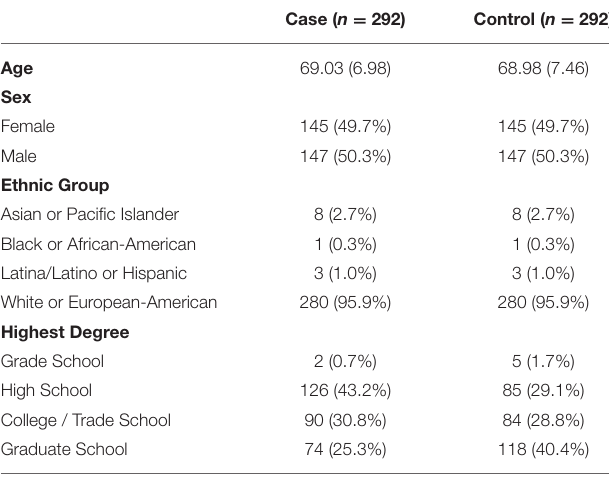
TABLE 3 | Demographics by case status.